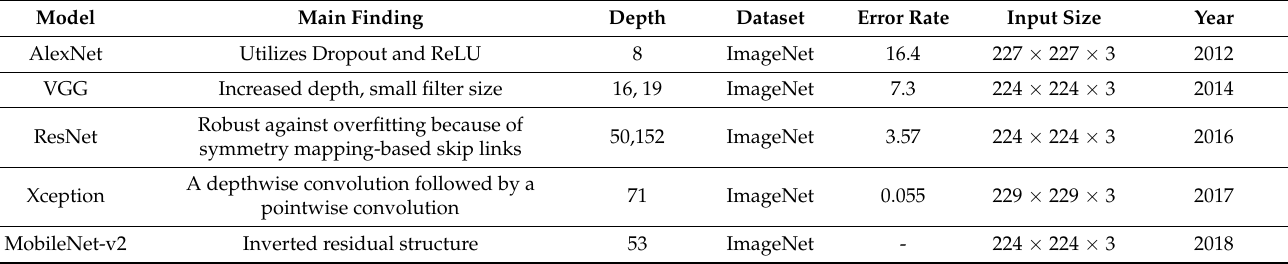
Table 4. Summary of the architectures of